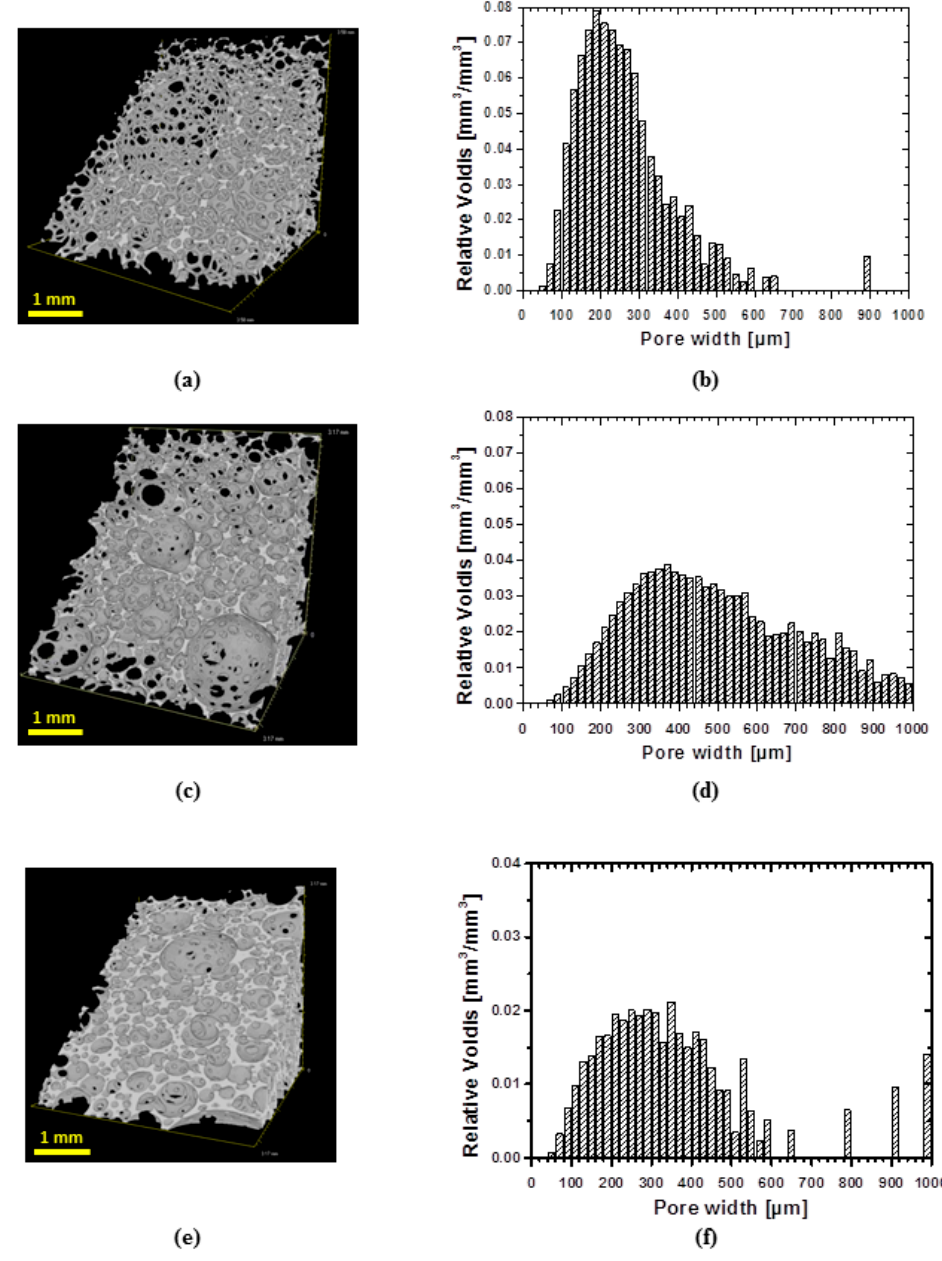
Figure 3. µCT images of 3D structure of water-blown PCL-polyol based Polyurethane (PU) foams illustrating the effect of density on foam architecture: ( a ) cPCL-2k-110 with porosity = 0.88 ± 0.09; ( c ) cPCL-2/4/8k-180 with porosity = 0.85 ± 0.09; and ( e ) cPCL-4k-220 with porosity = 0.73 ± 0.07. Pores volume distribution in relation to the pore sizes are depicted for: ( b ) cPCL-2k-110; ( d ) cPCL-2/4/8k-180; and ( f ) cPCL-4k-220.